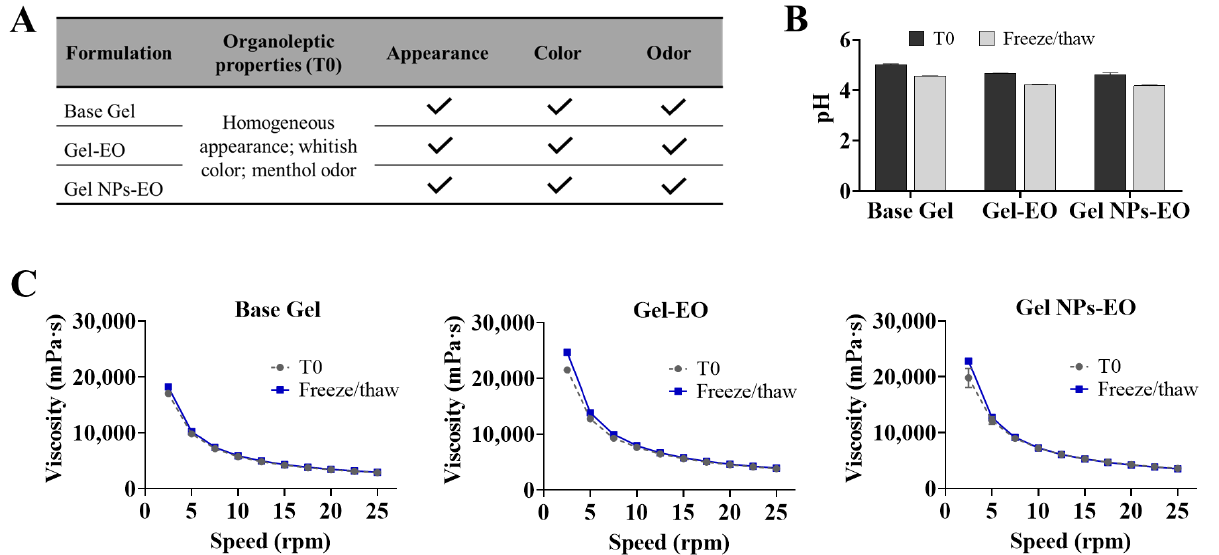
Figure 4. Evaluation of the organoleptic properties ( A ), pH ( B ) and viscosity ( C ) of the gels (Base Gel, gel containing free EO (Gel-EO) and gel containing EO-loaded chitosan nanoparticles (Gel NPs-EO)) after preparation (T0) and after five freeze/thaw cycles. Results are shown as the means ± standard deviations (SDs) of 3 replicates.